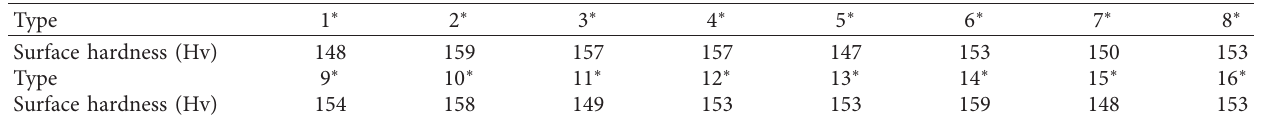
Figure 1: Photograph of thin film thickness using SEM equipment: (a) 30 ′ sputtered specimen; (b) 60 ′ sputtered specimen; (c) 90 ′ sputtered specimen; (d) thin film low magnification photo. Table 5: Surface hardness value (average).